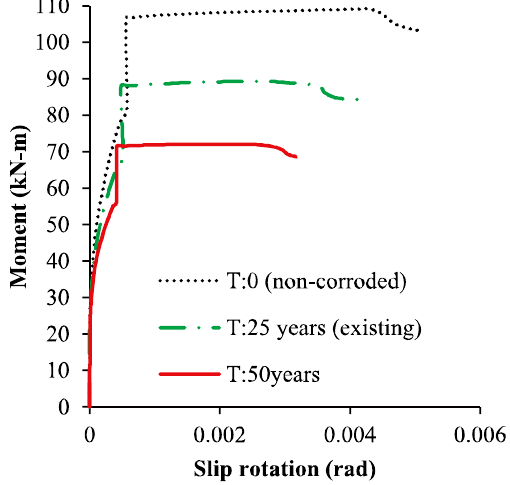
Fig. 9. Time-dependent slip rotation. Fig. 10. Time-dependent slip displacement.